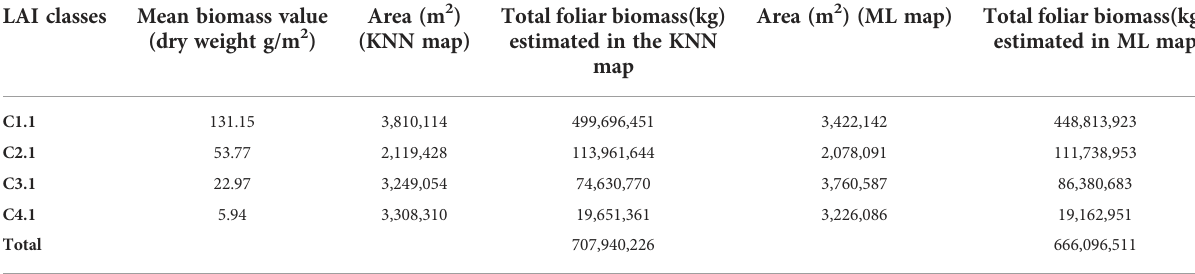
TABLE 4 Estimation of seagrass foliar biomass in the study area. LAI